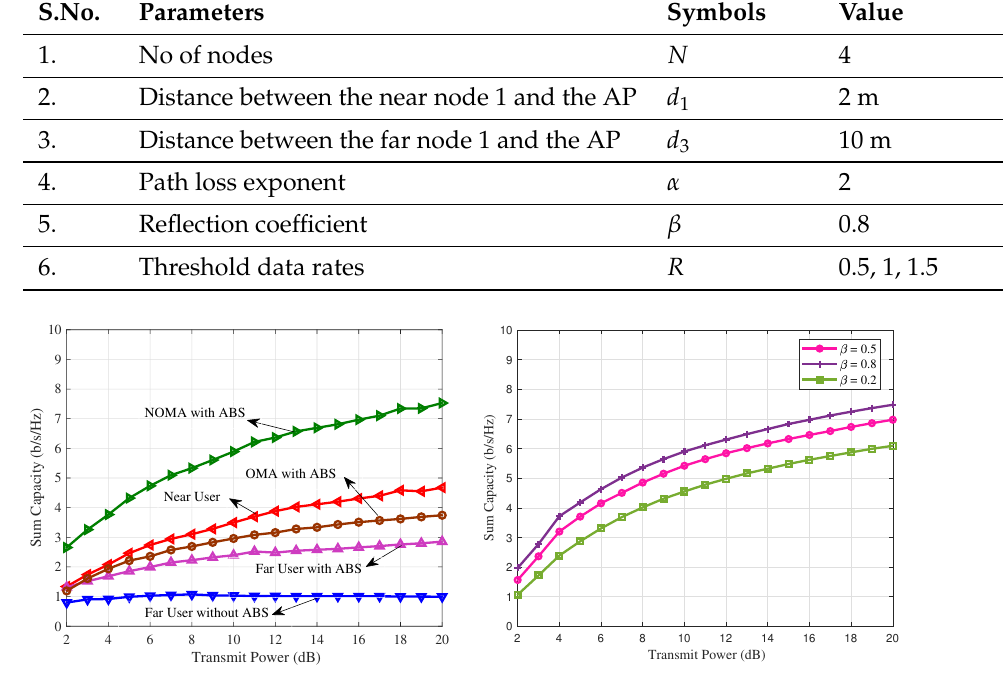
Table 2. Simulation Parameters.